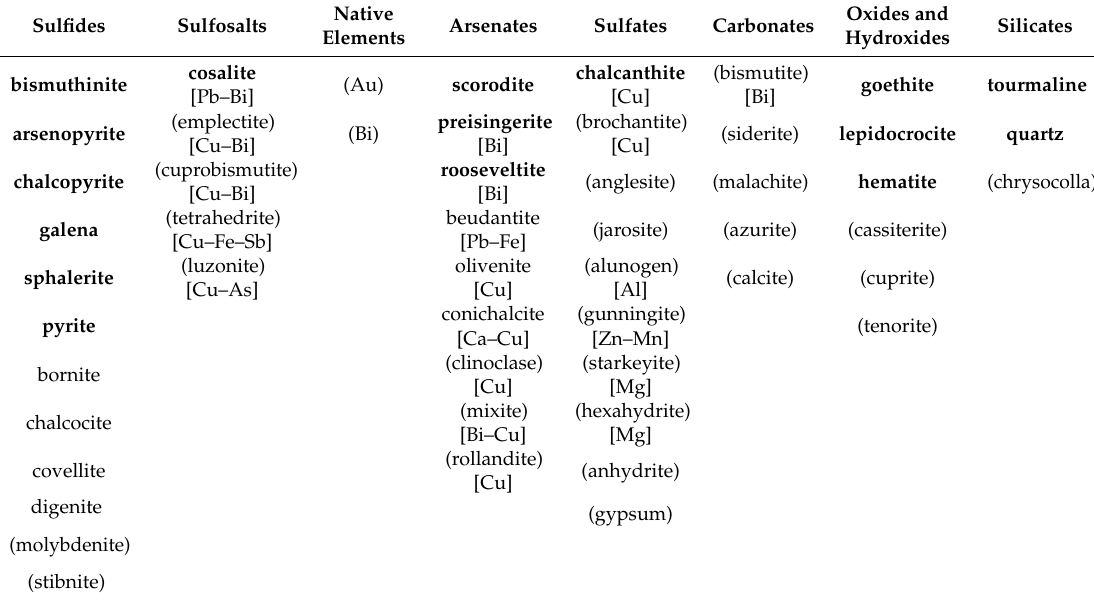
Table 2. Hypogene and supergene minerals identified at San Francisco de los Andes. Mineral types were confirmed by X-ray diffraction (Testa, 2016; unpublished data). The relative proportion of each mineral is expressed as: abundant (bold), minor (not bold), and trace concentrations (in brackets). The characteristic metals and metalloids for those less common minerals are listed between square